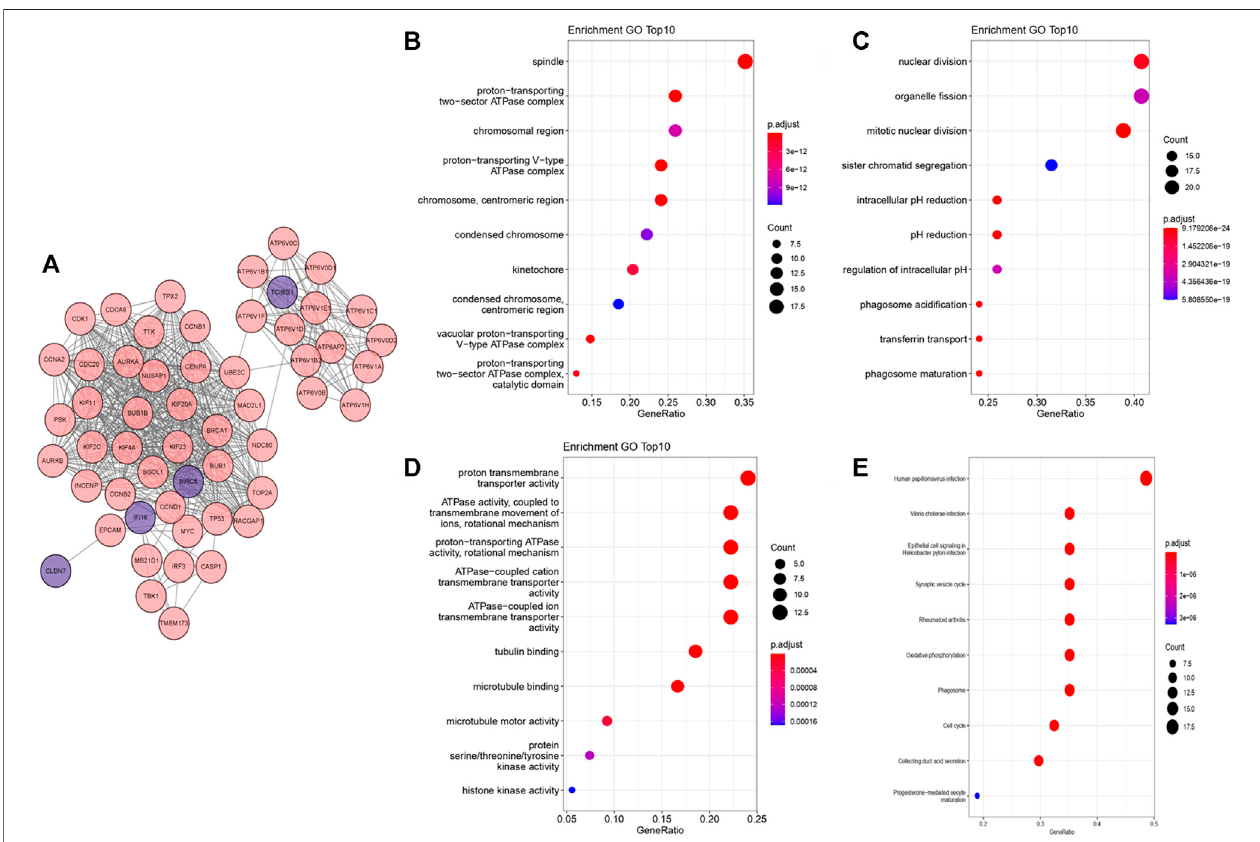
FIGURE 4 | PPI network and functional enrichment analysis from “ Clusterpro fi ler. ” The deeper the color is, the more signi fi cant the enrichment is. The bigger the bubble is, the more genes are participated in the term. (A) PPI network from STRING visualized by cytoscape. (B) Bubble map of top 10 enriched GO terms in CC. (C) Bubble map of top 10 enriched GO terms in BP. (D) Bubble map of top 10 enriched GO terms in MF. (E) Bubble map of top 10 KEGG enriched pathways.